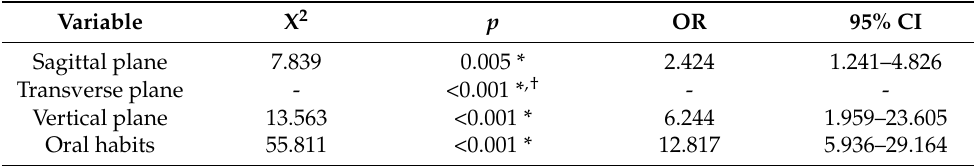
Table 2. Results of the statistical analyses for asthma and each variable studied.